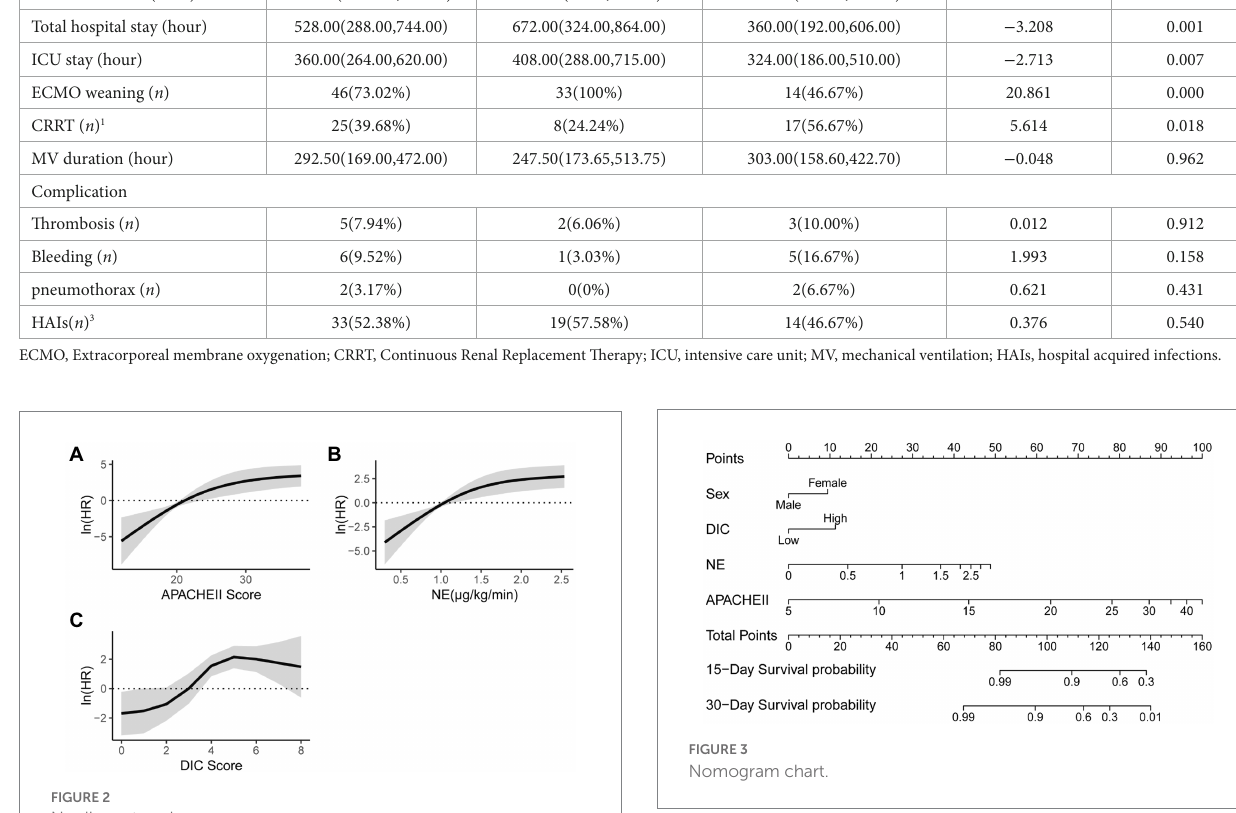
FIGURE 3 Nomogram